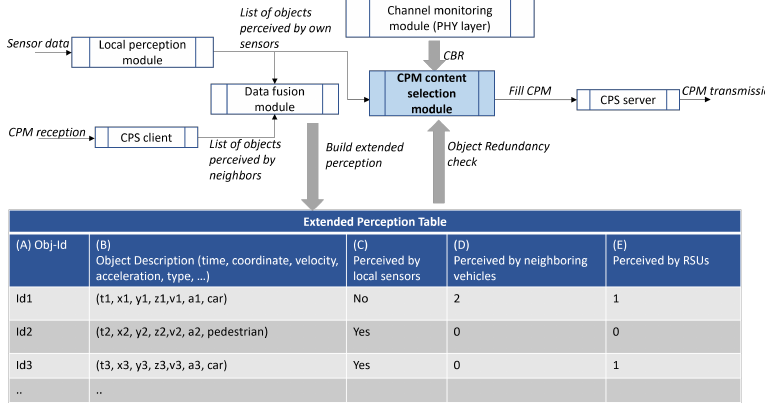
Figure 3. System diagram for Context-aware CPM generation and content selection.